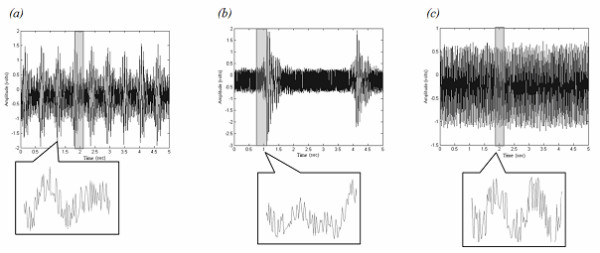
Recorded noise signals. Zoomed portions of the recorded noise during each of the three imaging sequences show various shapes. (a) IRSE noise (b) FSE noise, and (c) GE noise